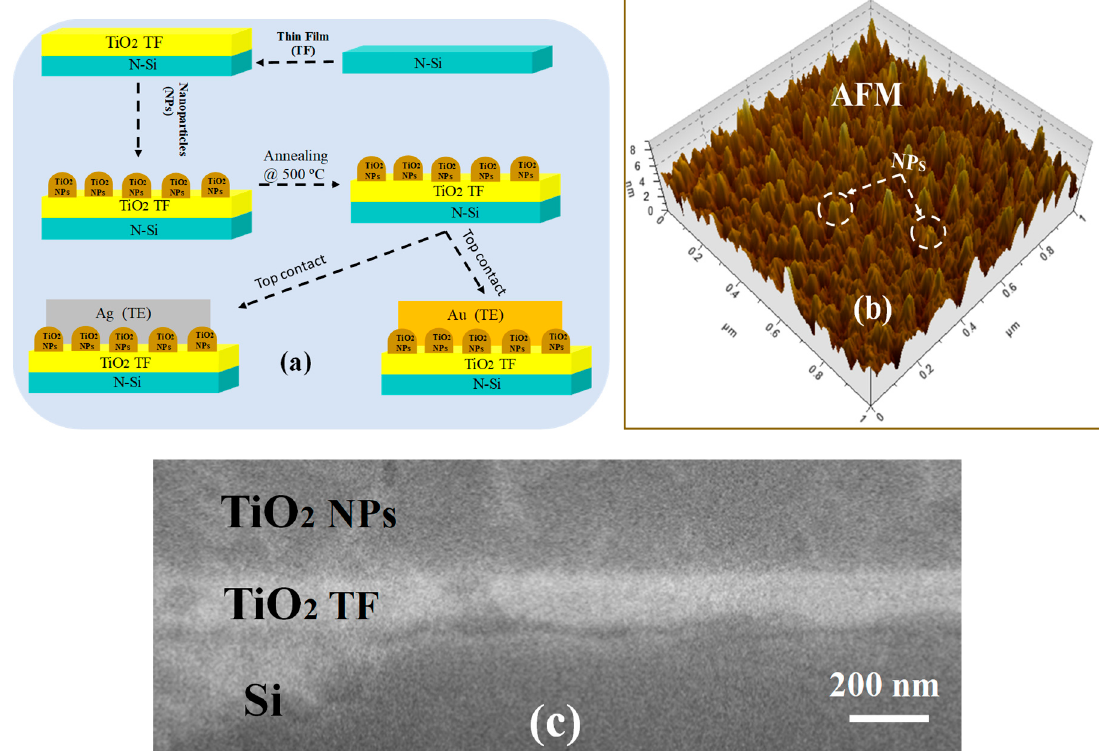
Figure 2. Devices with the ( a ) Schematic representation of fabrication process flow and ( b ) three-dimensional (3D) atomic force microscopy (AFM) image of the sample ( c ) Scanning electron microscopy (SEM) image of the Titanium Dioxide Thin Film (TF) (TiO 2 TF) and Titanium Dioxide Nanoparticles (TiO 2 NPs).